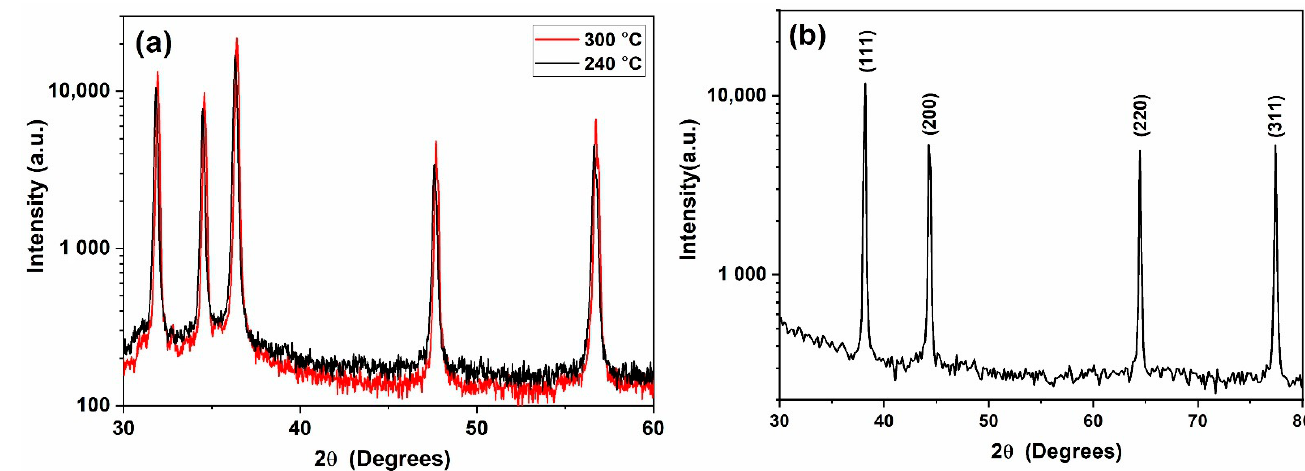
Figure 1. XRD pattern of ( a ) ZnO NP synthesized at 240 and 300 °C and ( b ) free-standing Ag NP.